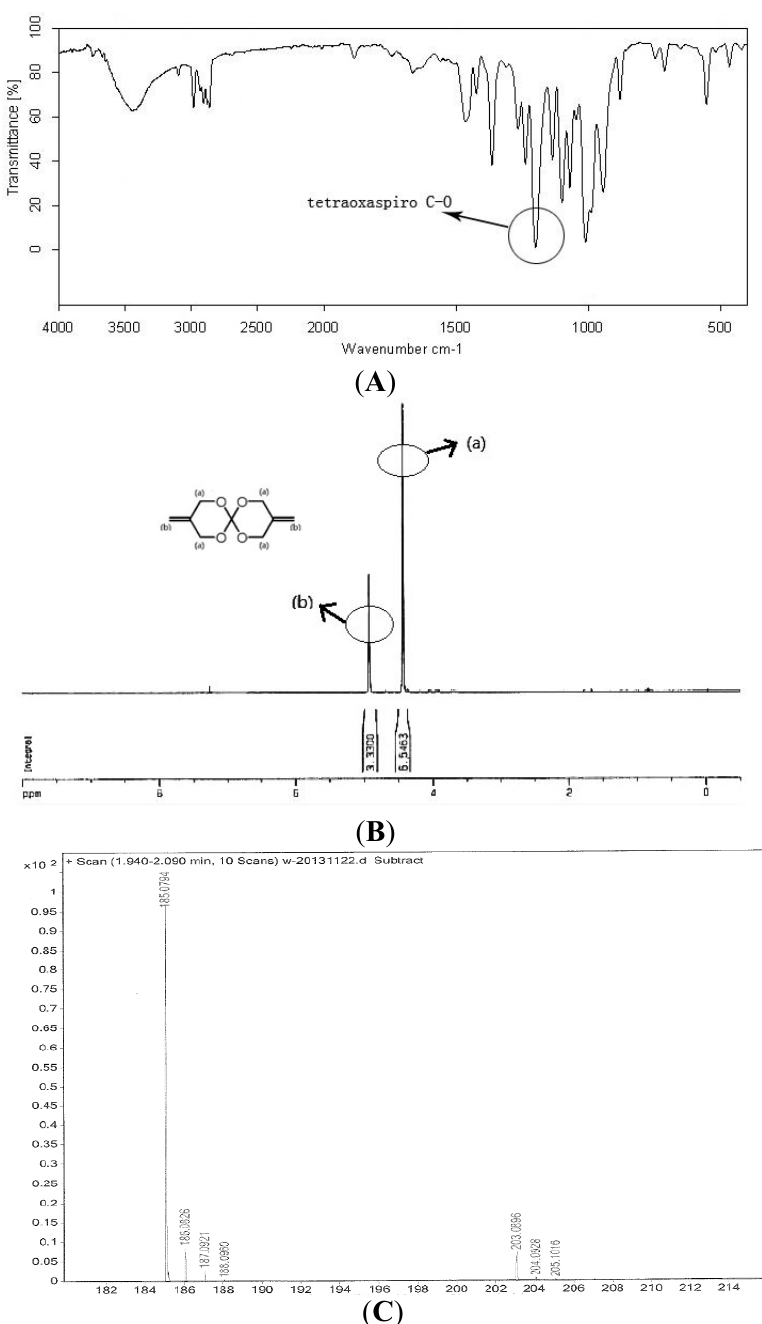
Figure 4. FTIR, 1 H NMR and MS of BMSOC. ( A ) FTIR spectra of BMSOC; ( B ) 1 H NMR spectra of BMSOC; ( C ) MS of